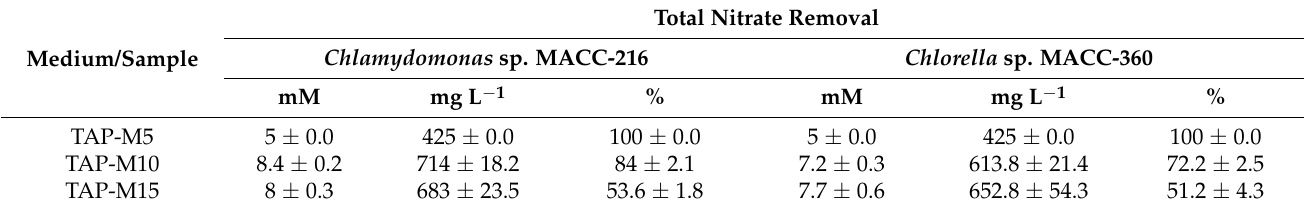
Table 2. Total nitrate removal by Chlamydomonas sp. MACC-216 and Chlorella sp. MACC-360 by 6th day. Values are represented as mean ± standard deviation.